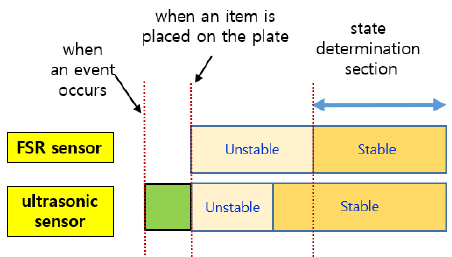
Figure 8. The sections for the FSR sensor and the ultrasonic sensor when putting in an item.